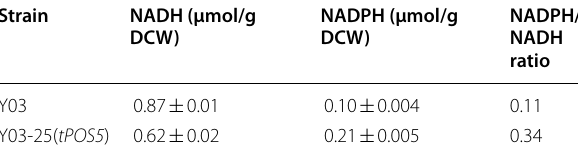
Table 1 Detection of intracellular NADPH and